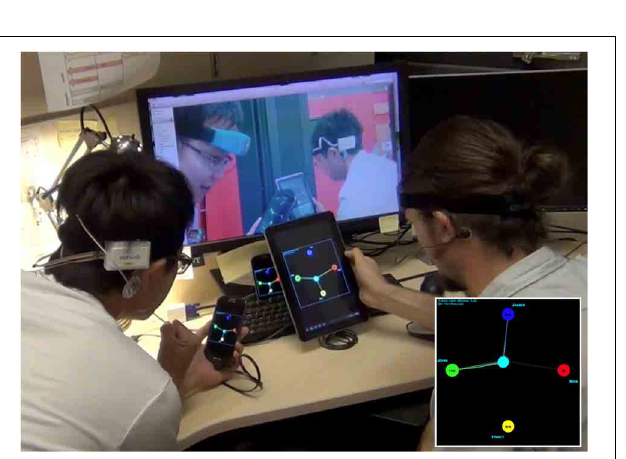
FIGURE 6 | Fog and Cloud Computing architecture for multiplayer on-line EEG-BCI game.